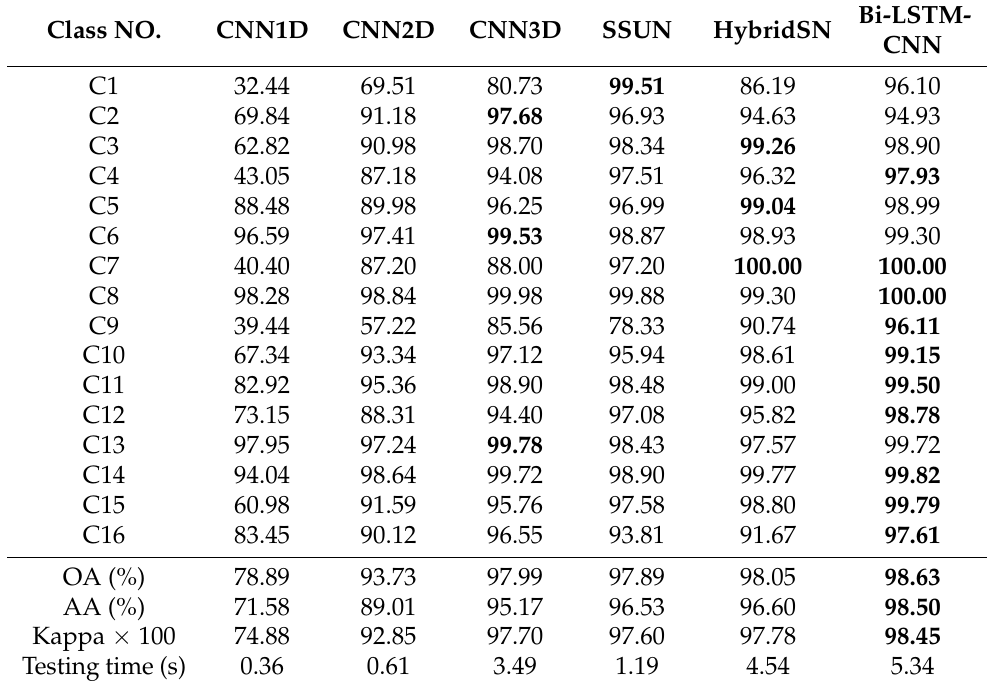
Table 7. Classification results for the IP dataset using 10% of the available labeled data. Class NO.